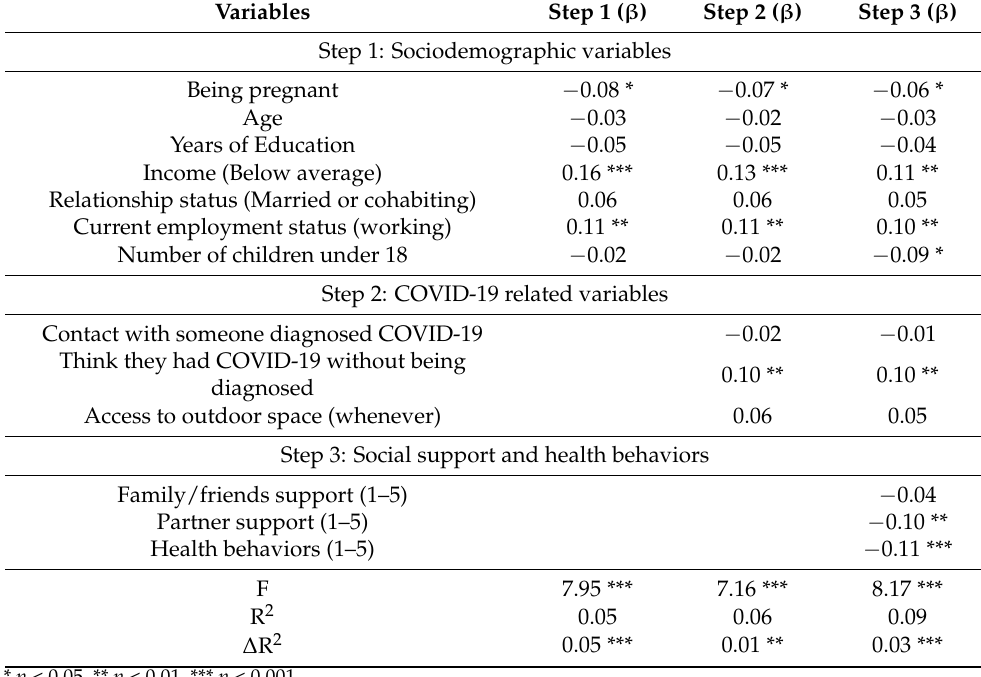
Table 2. Multiple hierarchical linear regression analyses—prediction of depression (PHQ-2) score among non-pregnant and pregnant